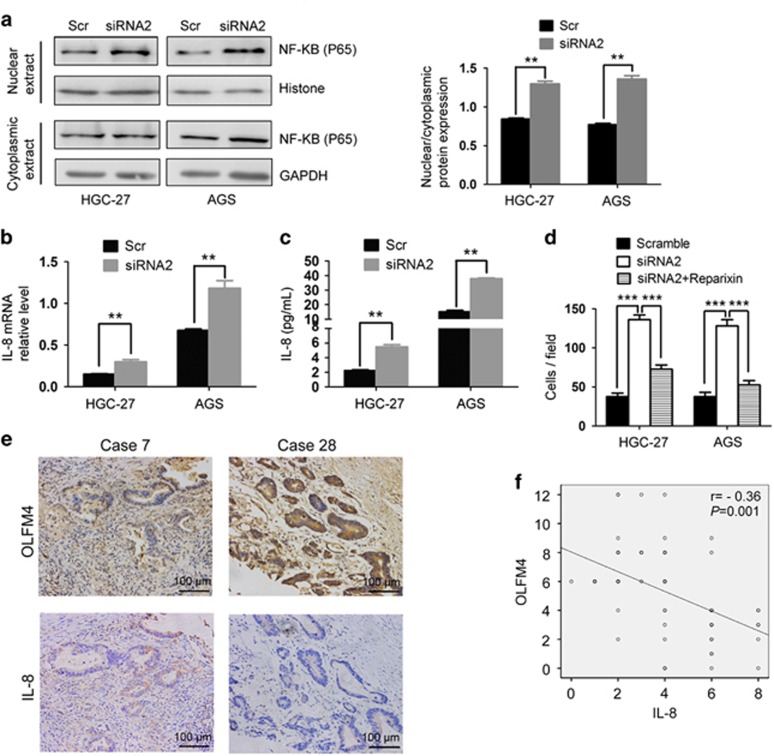
Depletion of OLFM4 induces NF-κB activation and IL-8 expression in gastric cancer. (a) HGC-27 and AGS cells were transfected as indicated. Forty-eight hours later, nuclear and cytoplasmic proteins were extracted and subjected to western blot analysis. (b) The effect of OLFM4 siRNA on IL-8 mRNA levels in HGC-27 and AGS cells were detected by real-time PCR. (c) The effect of OLFM4 siRNA on IL-8 protein levels in the supernatant of HGC-27 and AGS cells were detected by ELISA. (d) The effects of Reparixin (100 nM) on the migration of OLFM4-depleted gastric cancer cells were detected by transwell assay. (e, f) Correlation of OLFM4 with the expression of IL-8 in clinical EGC cases. Representative images in consecutive tumor sections were shown. Correlation between OLFM4 and IL-8 protein expression in 73 cases was analyzed. In (a–d), experiments were repeated three times, and error bars indicate means±s.e.m. **P<0.01; ***P<0.001; Scr, Scramble.